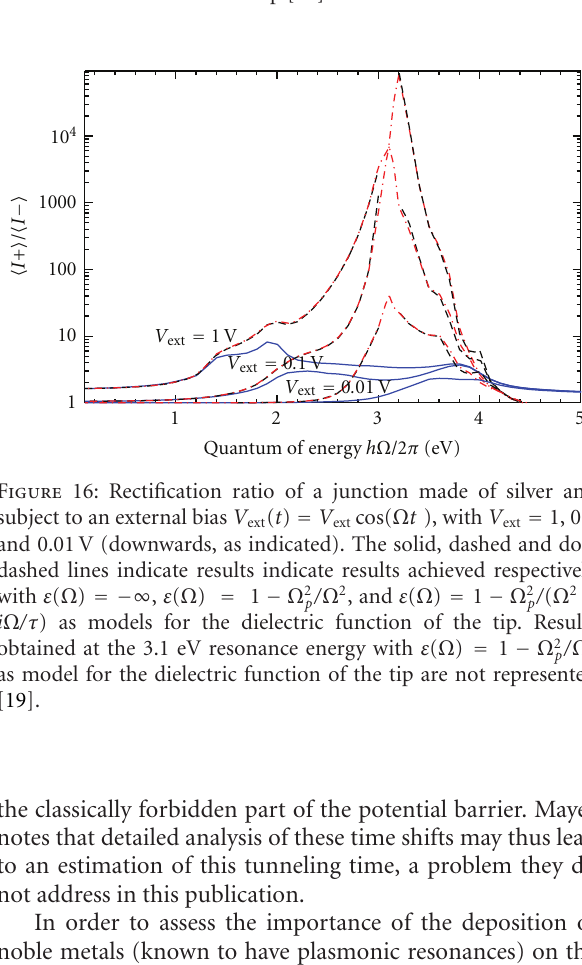
Figure 15: Rectification ratio of a junction made of tungsten and subject to an external bias V ext ( t ) = V ext cos( Ω t ), with V ext = 1, 0.1 and 0.01 V (downwards as indicated). The solid, dashed and dot- dashed lines indicate results achieved respectively with ε ( Ω ) = −∞ , / Ω 2 , and ε ( Ω ) = 1 − Ω 2 / ( Ω 2 + i Ω /τ ) as models for ε ( Ω ) = 1 − Ω 2 p p the dielectric function of the tip [19].